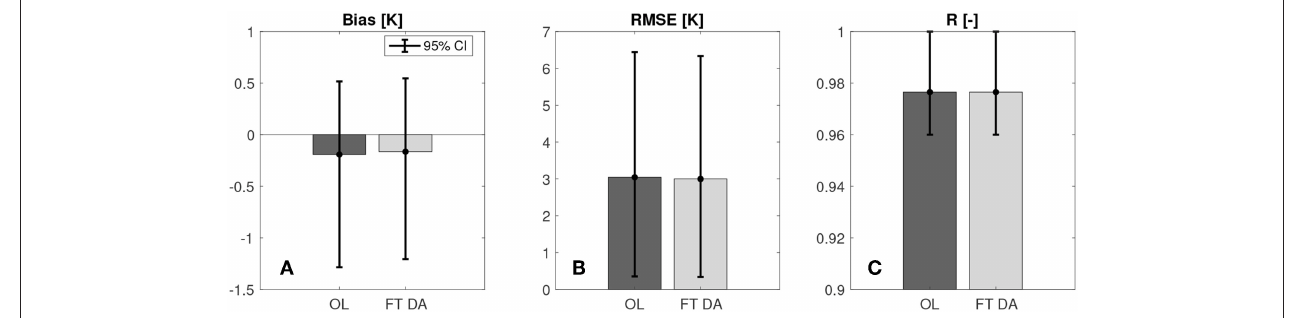
FIGURE 5 | Histogram of the average (A) bias, (B) RMSE, and (C) R computed by comparing OL, and FT DA against CMA ground-based surface temperature measurements. All histograms are supplemented with 95% confidence intervals. It is important to note that (C) does not start with